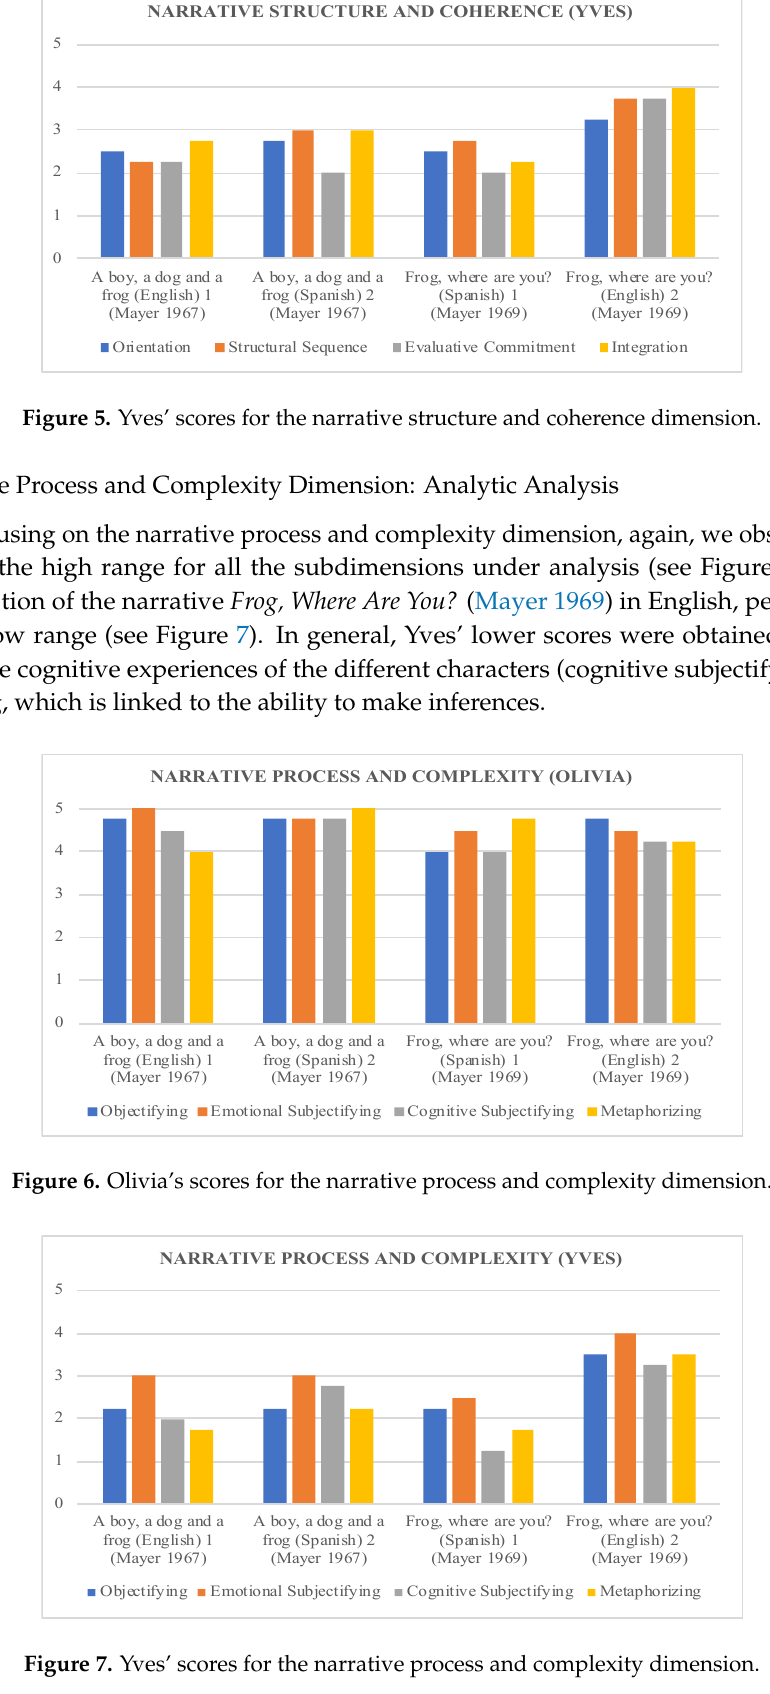
Figure 4. Olivia’s scores for the narrative structure and coherence dimension.